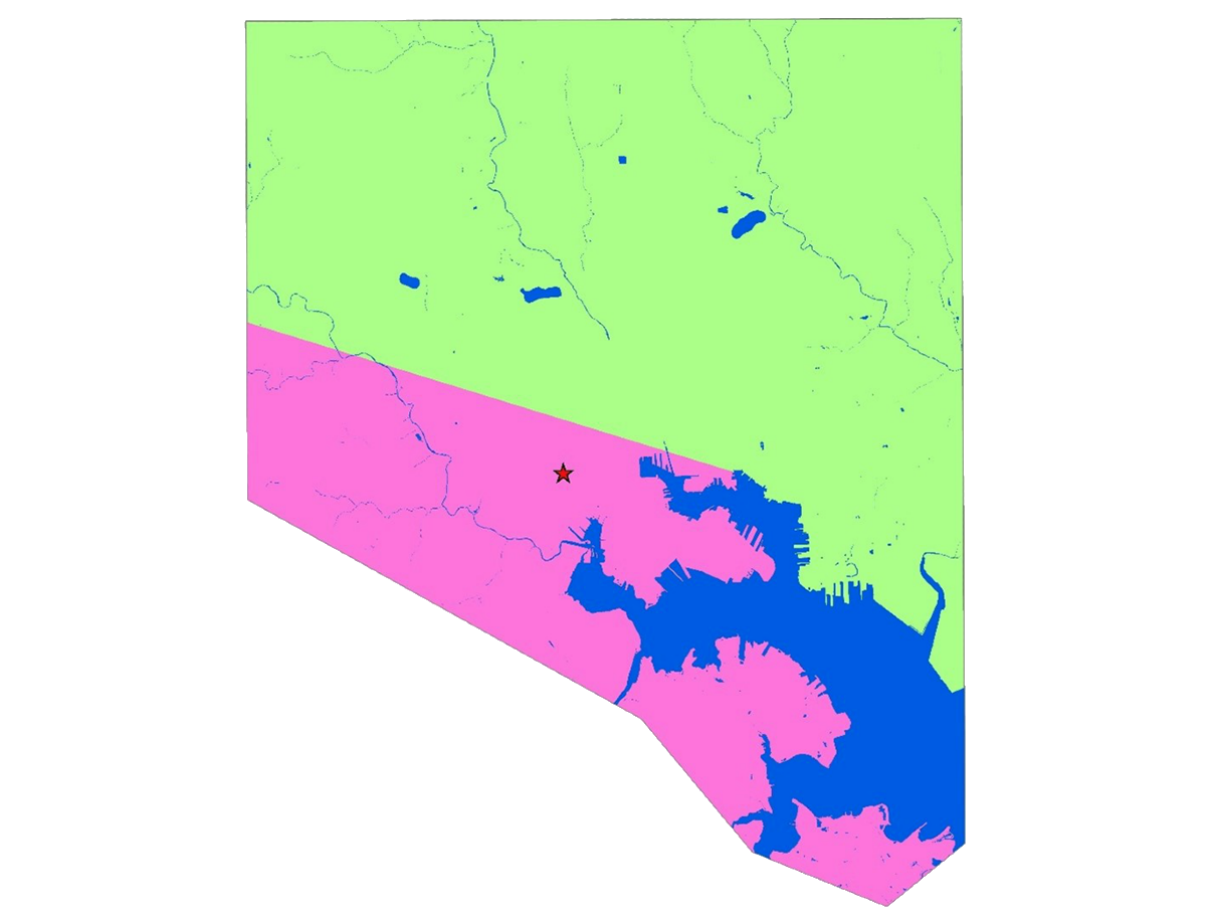
Figure 2. Map of EMERALD (Enabling Mobilization, Empowerment, Risk Reduction, and Lasting Dignity) intervention and control areas. Red star=SPARC (Sex Workers Promoting Action, Risk Reduction, and Community Mobilization) center, blue=water, pink=intervention area, and green=control